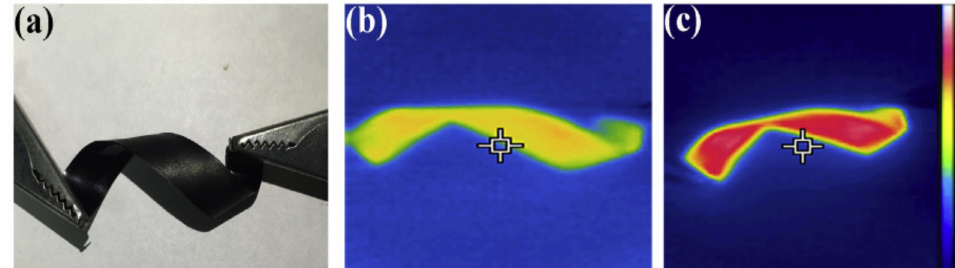
Figure 5. ( a ) An image of a twisted CNT film; IR camera images of the same CNT film heated to ( b ) medium and ( c ) high temperatures [173]; copyright Elsevier